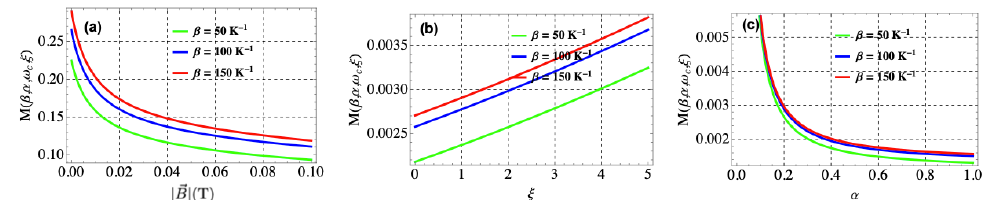
Figure 6. Plot of magnetization as function of ( a ) magnetic field | (cid:126) B | ( T ) , ( b ) AB field ξ and topological defect α ( c ) for different values of β = 50 k − 1 (green curve), 100 k − 1 (blue curve) and 150 k − 1 (red curve); all other parameters are same as in Figure